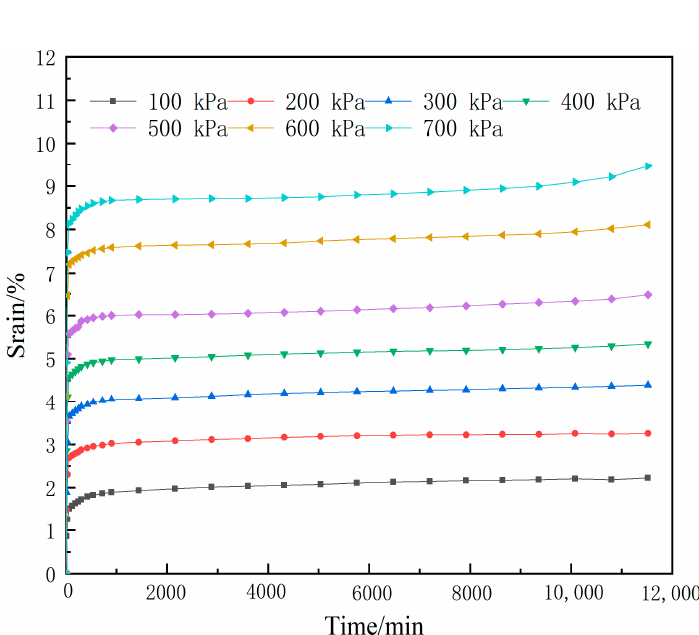
Figure 3. Strain – time curves of sandy soil with di ff erent vertical loads. Figure 3. Strain–time curves of sandy soil with different vertical